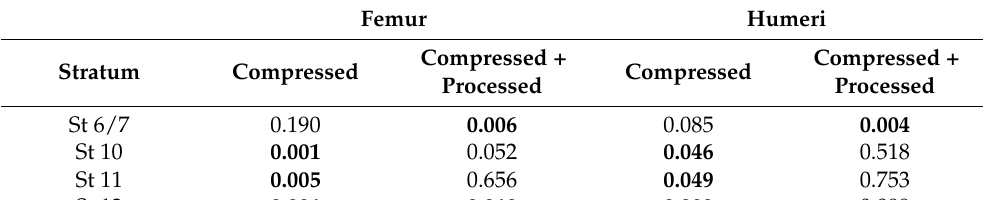
Table 6. Simulate p -values obtained from the Fisher’s Exact Test using the data showed in Table 5 compared to Wonderwerk sample assemblages published in Marin-Monfort et al. [30]. Values in bold indicate significant differences ( p -value ≤ 0.05).